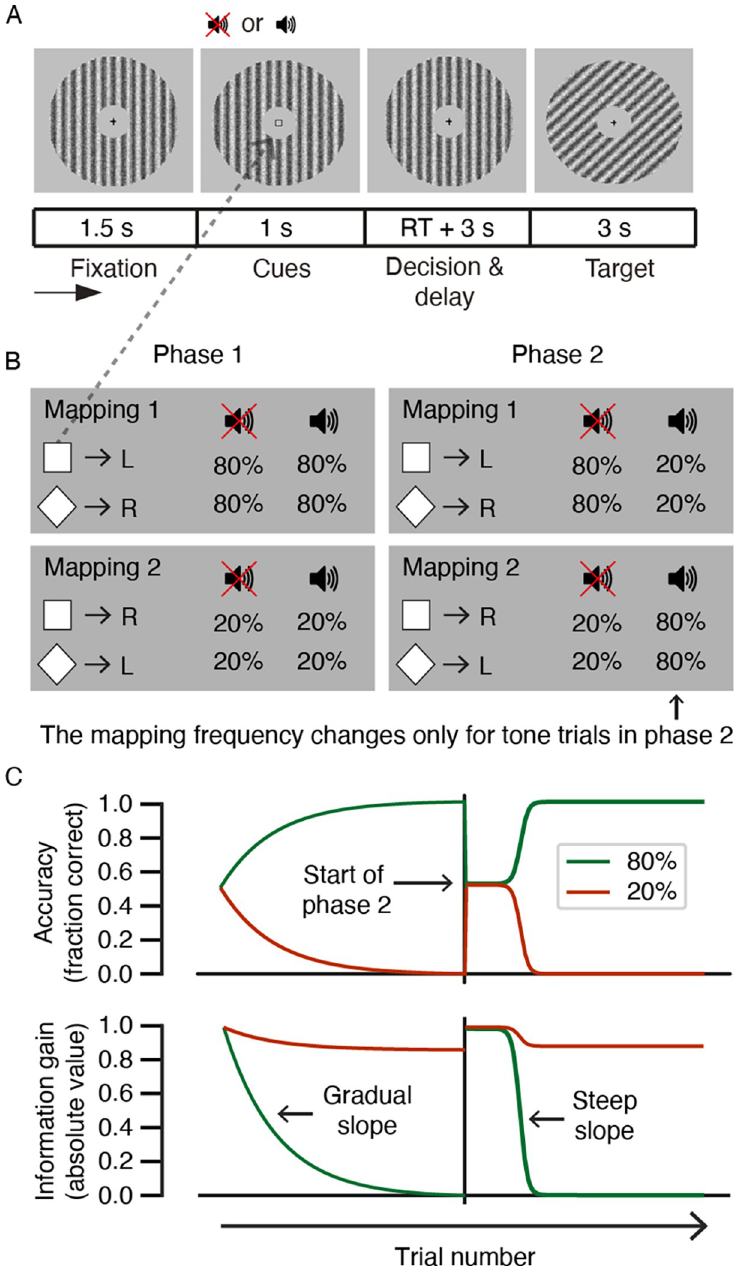
Fig 1. Experimental design and hypotheses. ( A ) Trial structure of the behavioural task. Participants performed a 2AFC task on the expected orientation (left/right) of upcoming Gabor patches while pupil dilation was recorded. Each trial consisted of a fixation period, a cue period, a response window followed by a delay period, and finally a target period. The decision interval ranged from onset of the cue to the participant’s response. The target interval ranged from target onset into the subsequent inter-trial interval (3 s). The target served as feedback on the accuracy of participants’ predictions in the decision interval. ( B ) An illustration of one of the two counterbalanced cue-target mappings. The participants had to learn cue-target contingencies to accurately predict the orientation of the upcoming Gabor patch (target). Mapping 1 was defined as the visual cue-target pairs that occurred in 80% of trials in the first phase; Mapping 2 was defined as the visual cue-target pairs that occurred in 20% of trials in the first phase. Mappings were counterbalanced between participants (i.e., half of the participants received the square - > left, diamond - > right mapping in the 80% condition in phase 1). At the start of the second phase, the frequencies (80% vs. 20%) of the cue- target mappings were reversed for trials containing the auditory tone cue only. ( C ) Main hypotheses for the dynamics of accuracy and information gain following the target presentation over the course of the 2AFC task. The first 200 trials